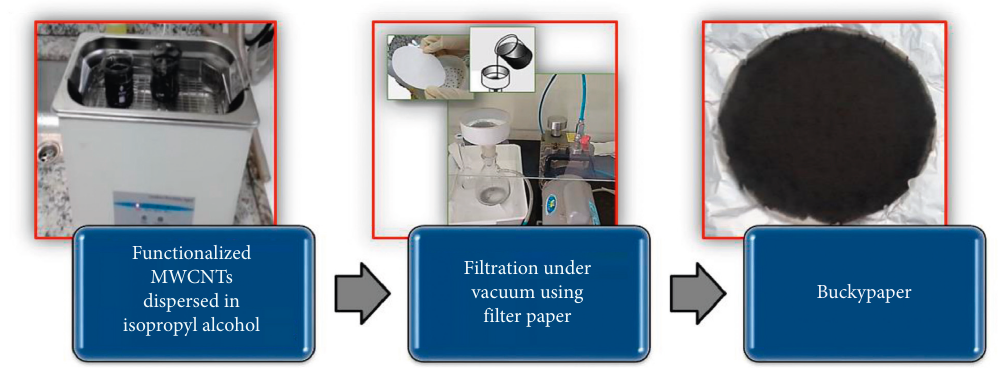
Figure 2: Manufacturing process of the BP by vacuum